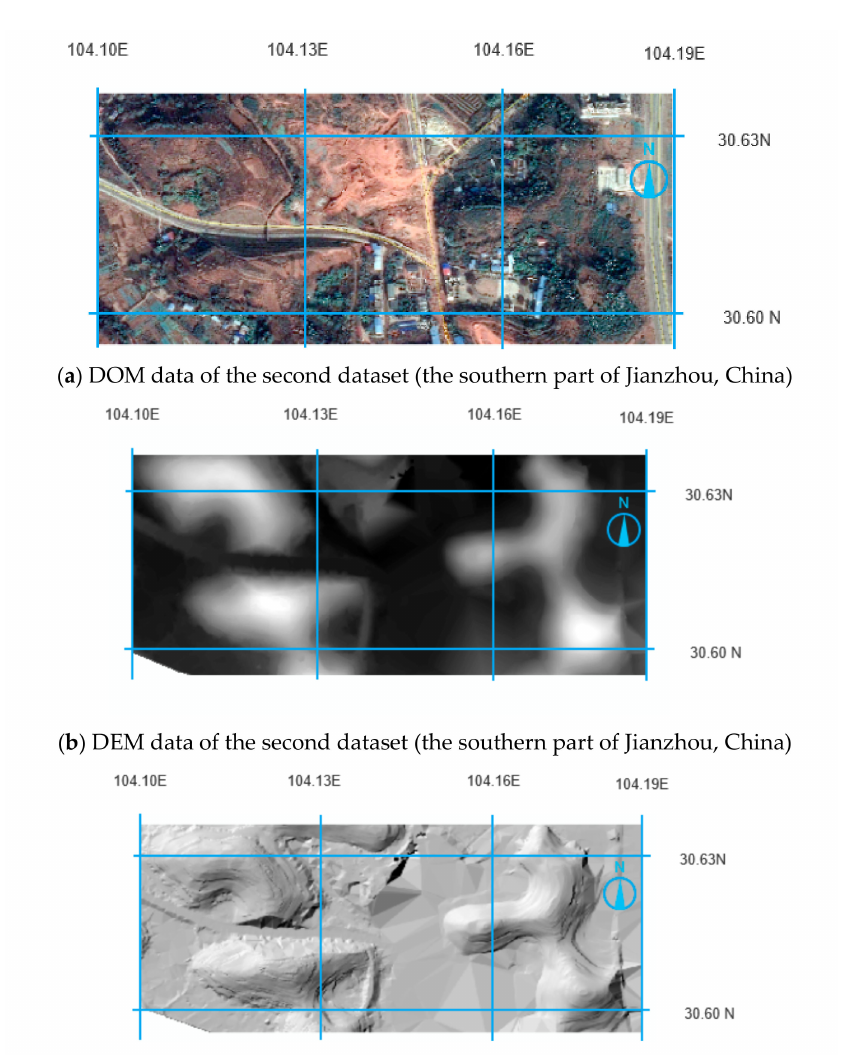
Figure 12. The experimental second dataset: ( a ) DOM data of the second dataset (Jianzhou); ( b ) DEM data of the second dataset (Jianzhou); ( c ) Hillshading result of the second dataset